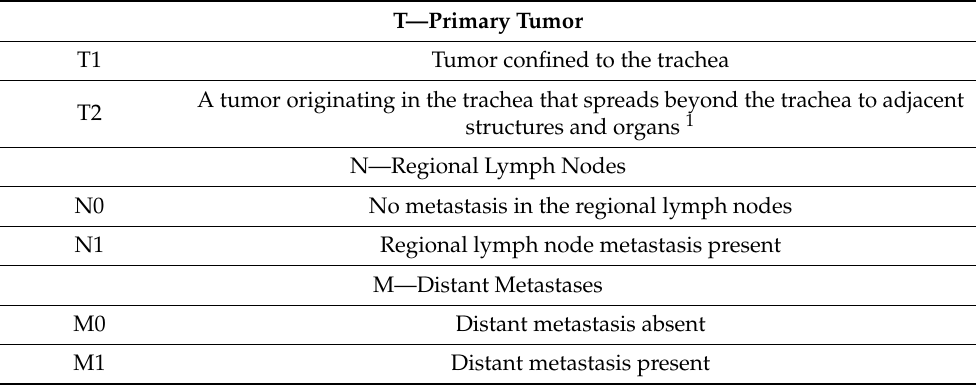
Table 1. Adopted clinical TNM